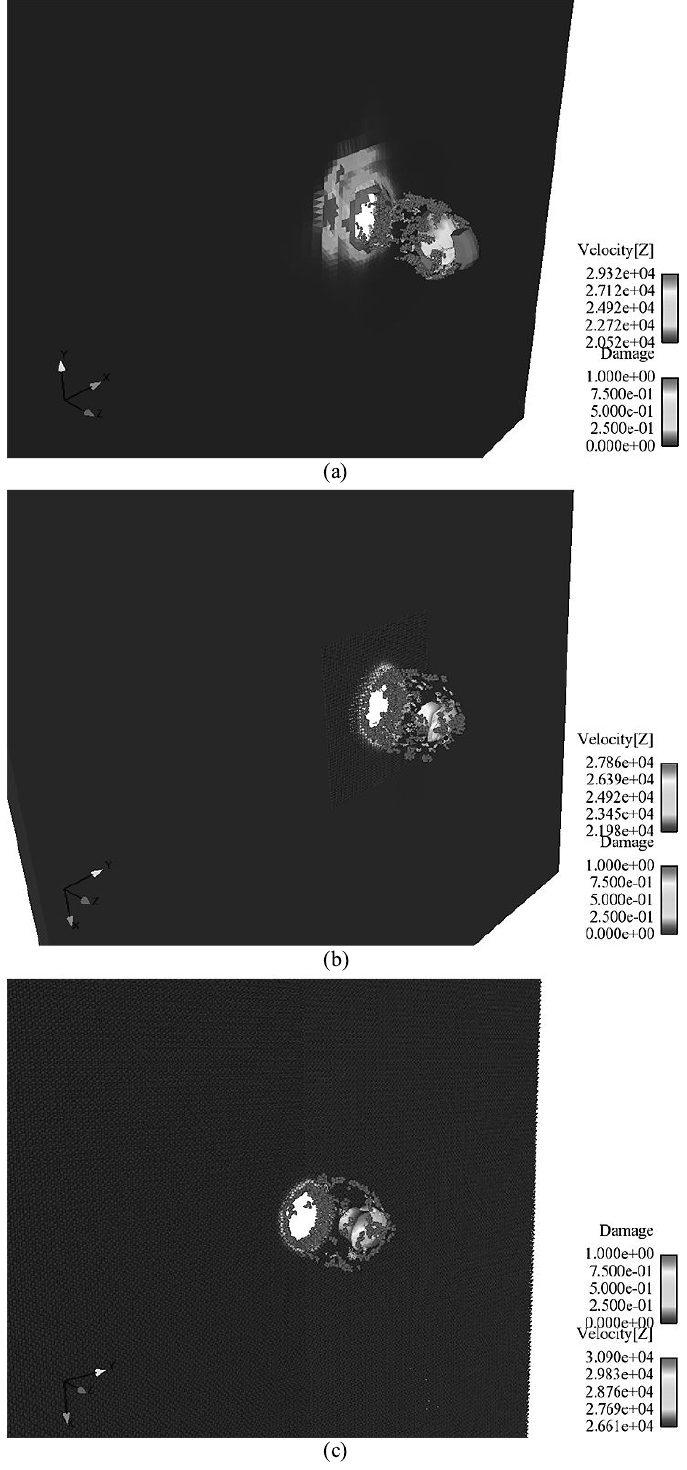
Fig. 10. Projectile penetration and panel damage for (a) conversion case, (b) combined particle/element mesh, and (c) total particle